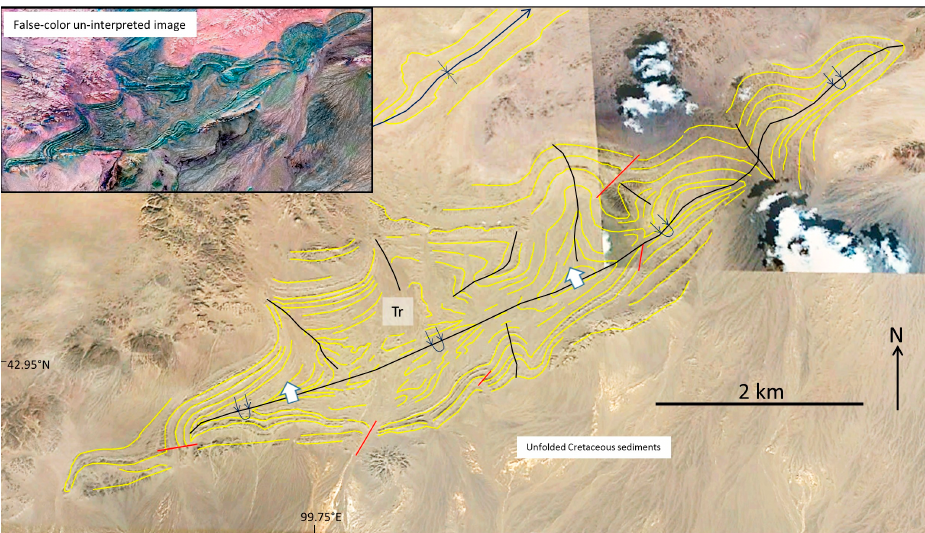
Figure 5. Google Earth (© 2016 CNES/Spot) image interpretation showing bedding traces (yellow lines) and major fold hinges in folded mid-upper Triassic (Tr) rocks in SW Tost Uul region, southern Mongolia. Thick white arrows indicate direction of fold vergence. Inset shows Landsat TM MrSID (N-47-40_2000) un-interpreted scene that was linearly contrast stretched, filtered (3 × 3 median), and color enhanced using the Global Mapper Difference tool. See Figure 1 for location.